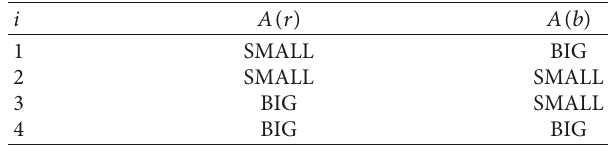
Figure 1: Membership functions of (a) visibility and (b) curve radius. Table 1: Combinations of input variables in fuzzy